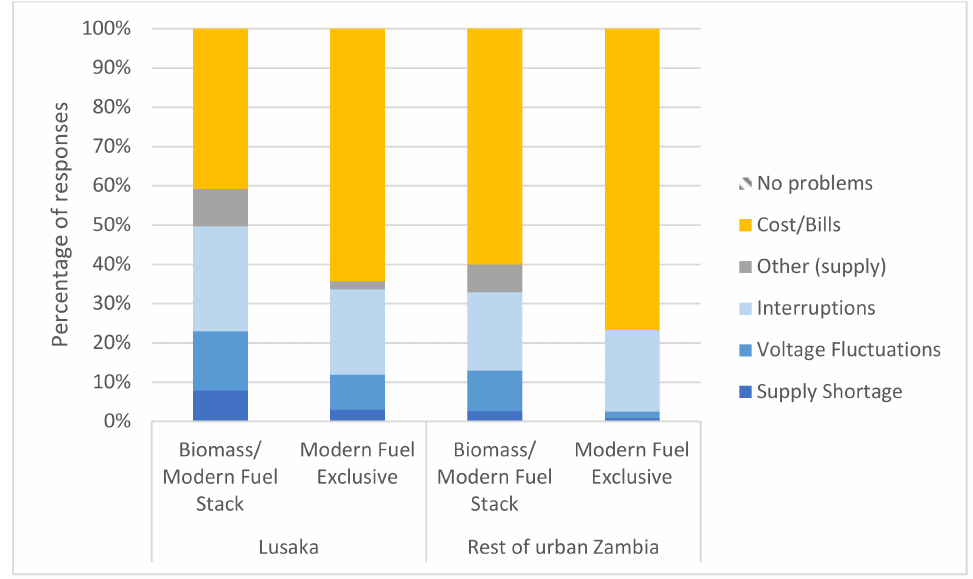
Figure 5. The main problems with a household’s electricity supply, Zambia (up to two responses per household).